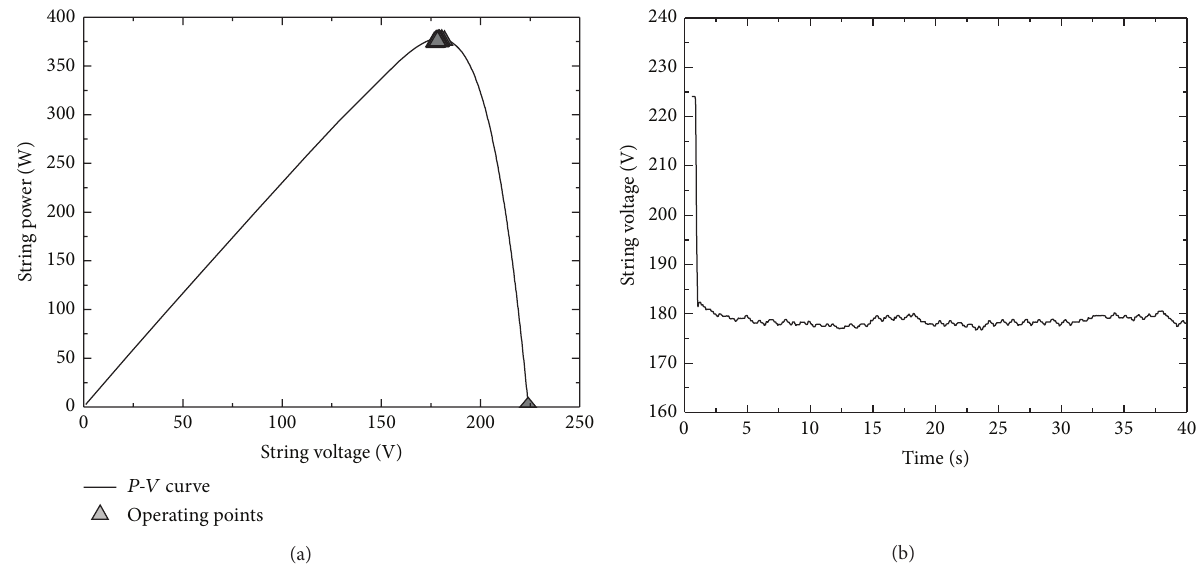
Figure 11: Sunny case. (a) Experimental power-voltage characteristic (solid line) of the 10-panel test string under full irradiation. The operating points of the string (triangles) by adopting the information based MPPT algorithm are shown. (b) String power against the